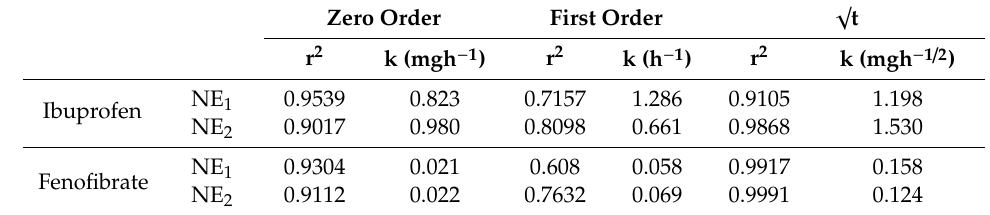
Table 1. Values of the correlation coe ffi cients (r 2 ) and drug release rate constant (k) obtained by fitting ibuprofen or fenofibrate release data from NE 1 and NE 2 with zero-order, first-order and square of time release mathematical models.